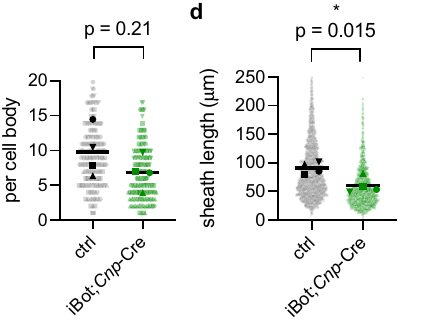
60.5±7.4 μ m.Statisticalmeasurements( p -value)weredetermined byanunpaired, two-tailed t-test. Source data are provided in the Source Data fi le. e Schematic of a brainregion containing sparsely myelinated fi bers at P12 examined in f – h . Created with BioRender.com. f Immunolabeling of P12 mouse sagittal brain slices from control (top) and iBot; Cnp- Cre (bottom) littermates for MBP (magenta) and GFP (green). Control samples do not show GFP signal, since iBot is not expressed. Imagesarerepresentativeof n =5controland n =4iBot; Cnp -Cremicequanti fi edin g , h . Scale bar, 20 μ m. Source data are provided in the Source Data fi le. Quanti fi - cation of sheath length from P12 brain slices depicting scatter plots ( g ) and histo- gramdistribution( h )betweencontrol(gray)andiBot; Cnp -Cre(green).Squaresand circles denote males and females, respectively. Mean sheath length±SEM: control 54.2±3.81 μ m, iBot 39.6±2.38 μ m from n =5 (control) or 4 (iBot; Cnp -Cre) biolo- gicallyindependentreplicateswith441 – 472totalsheathsquanti fi edpercondition. Statisticalmeasurement( p -value)wasdeterminedbyanunpaired,two-tailedt-test. Source data are provided in the Source Data fi